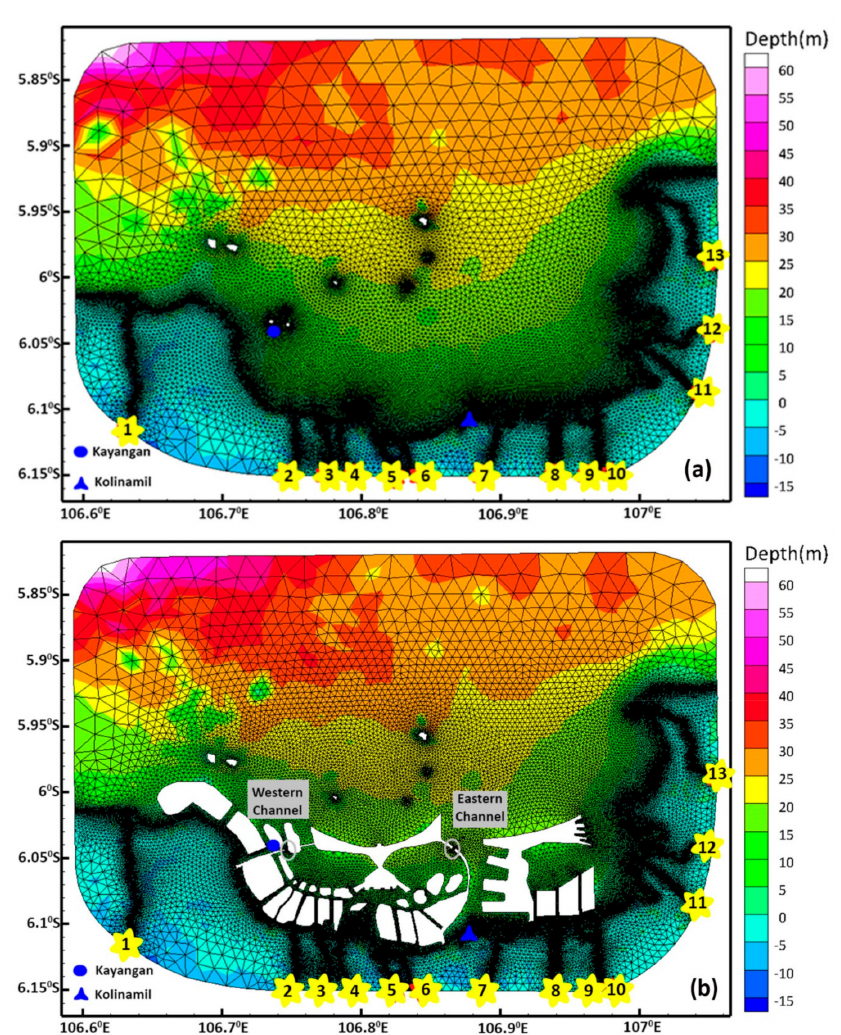
Figure 3. Model Grid for Jakarta Bay ( a ) reference scenario 1 and ( b ) Jakarta Bay after the Giant Seawall (GSW) construction (scenario 3). The numbers indicate rivers. The blue dot and triangle indicate field